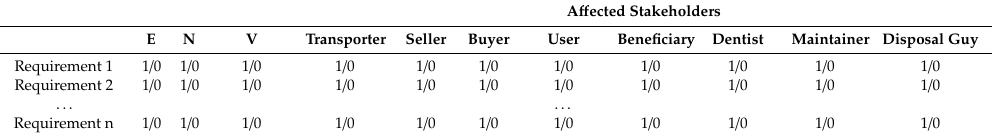
Table 5. Table used to assess the requirement sets produced by each subject. “1” or “0” are attributed to each of the ENV if the parameters are present or are missing, respectively. “1” is assigned to each stakeholder actually a ff ected by the requirement.